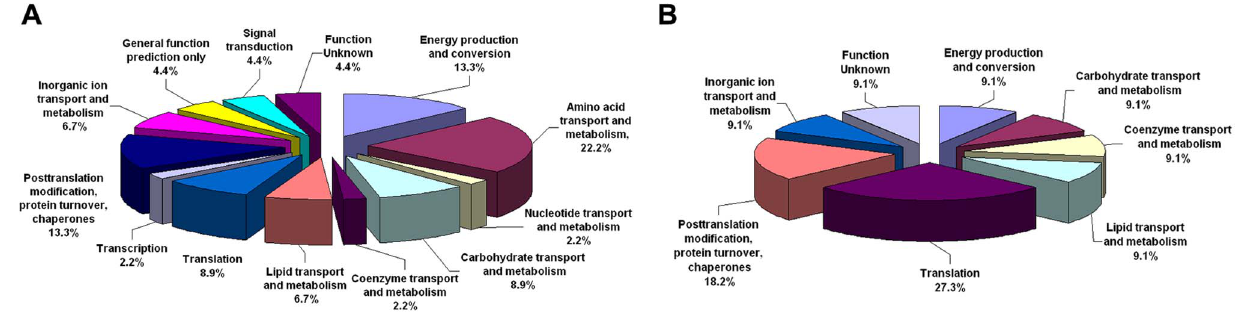
Figure 2. Graphic representation of the immunogenic proteins categorized according to cellular function. (A) B.anthracis vaccine strain A16R vegetative proteins; (B) B.anthracis vaccine strain A16R spore proteins.